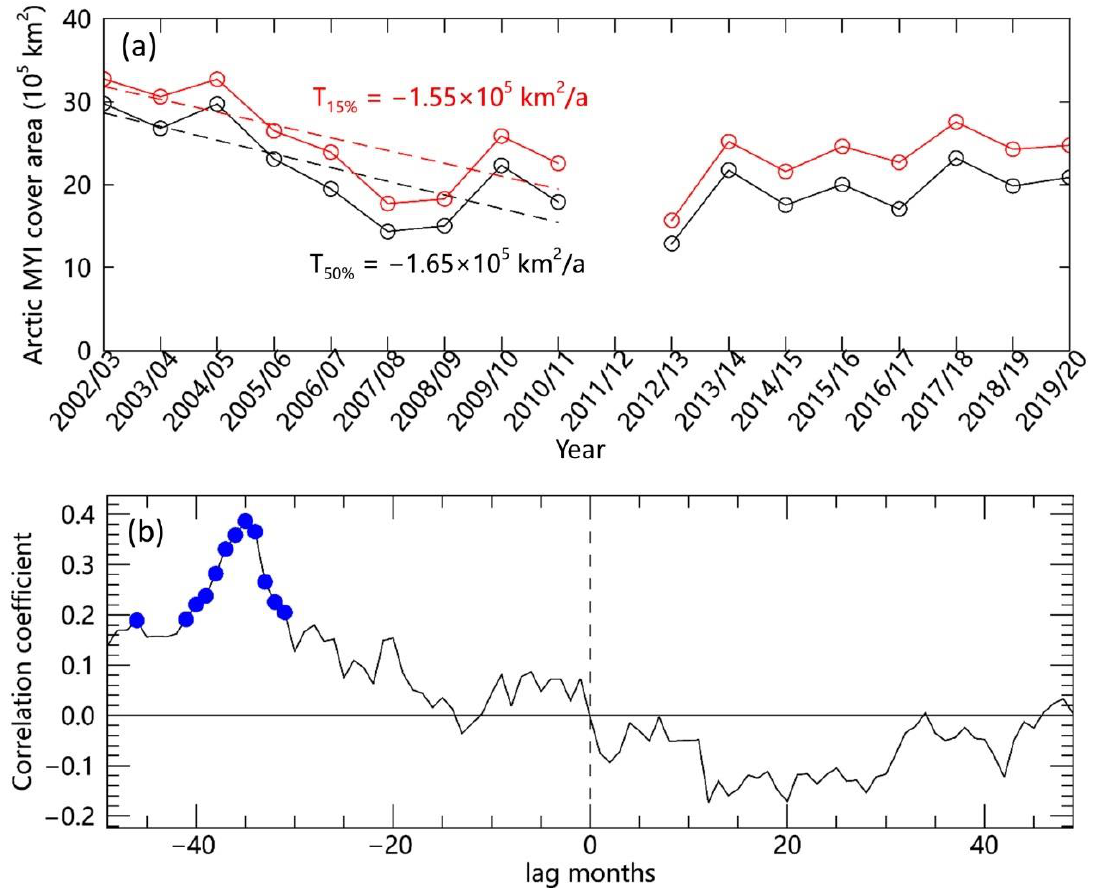
Figure 5. Correlation between Mean area of MYI cover in the Arctic ocean and MYI export via FS for winter seasons. ( a ) Mean Arctic MYI area. The red (black) line indicates 15% (50%) as a cutoff for the lowest MYI concentration to obtain the Arctic MYI area. The MYI area trends during D1 are significant at the 95% confidence level, whereas the trends are not significant during D2. ( b ) Correlations as a function of lead and lag months between monthly MYI area export and Arctic MYI area anomalies. The blue circles represent confidence levels above 95%. Negative lags represent the MYI area export